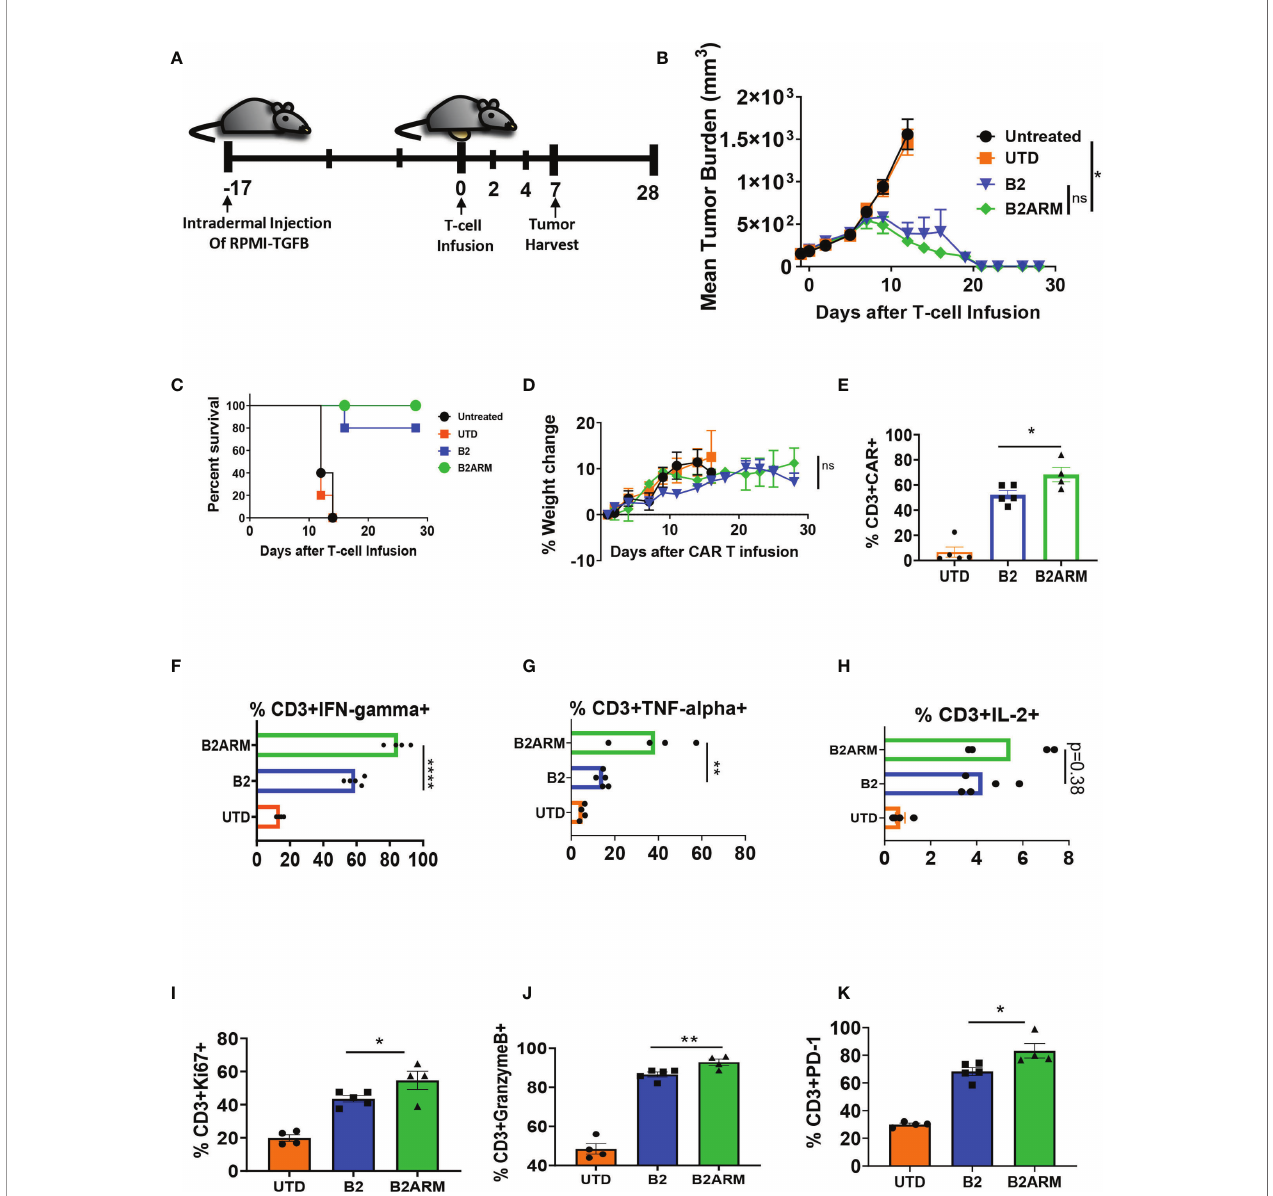
FIGURE 7 | The B2ARM CAR with exhibits superior ef fi cacy in vivo . (A) NSG mice were intradermally injected on the abdomen with 8 x 10 6 RPMI-8226 cells with overexpressed TGF- b (n = 10 in all groups except untreated, n = 5). On day 17 after tumor injection, 5 x 10 6 CAR+ T-cells were intravenously injected. The differences in CAR expression levels were normalized by adjusting the total number of infused T-cells. On day 7 after T-cell infusion, 5 mice from each group (except the untreated group) were sacri fi ced for tumor harvest, while the rest were monitored for (B) tumor progression, (C) survival, and (D) weight change. (E) the percentage of CD3+CAR+ T cells in the tumor homogenates was determined by fl ow cytometry following tumor harvest. Tumor homogenates were incubated at 37°C for 5 hours in the presence of brefeldin A, and (F) IFN- g , (G) TNF- a , and (H) IL-2 cytokine production in CD3+ cells was determined by intracellular staining and fl ow cytometry analysis. Statistical signi fi cance was determined by one way ANOVA with Tukey ’ s post-hoc test, *p<0.05, **p<0.01, ****p<0.0001. The percentage of Ki67, (I) , Granzyme B, (J) , and PD-1, (K) expression in CD3+ cells from TIL populations was determined by intracellular or surface staining and fl ow cytometry in tumor homogenates following tumor harvest. Statistical signi fi cance was determined by Student t-test, *p<0.05, **p<0.01, ns, non-speci fi